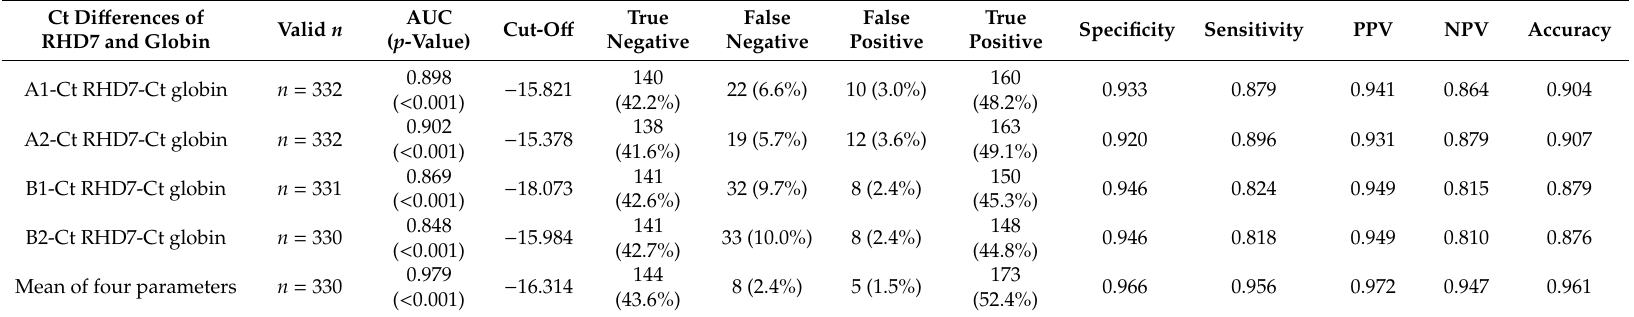
Table 3. ROC analysis of diagnostics tests and the predictive power of identified cut-o ff